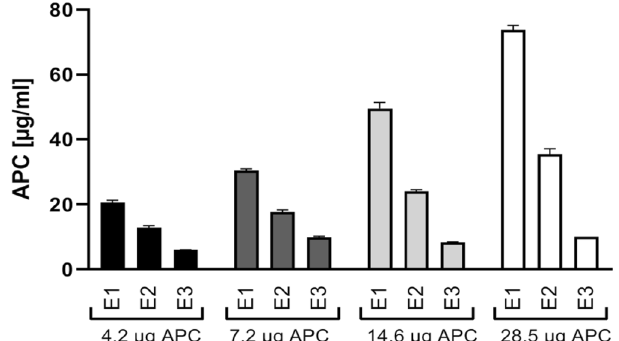
Figure 5. Capturing and elution of APC using HS02-52G coupled MyOne beads. Different amounts of APC were added to 500 µl binding buffer followed by APC capturing with MyOne beads coupled to HS02-52G aptamer and elution using elution buffer containing 5 mM EDTA. The eluted APC in consecutive elution steps (E1 to E3) was quantified by an activity assay using an APC standard curve. Data are shown as mean ± SD of three measurements.